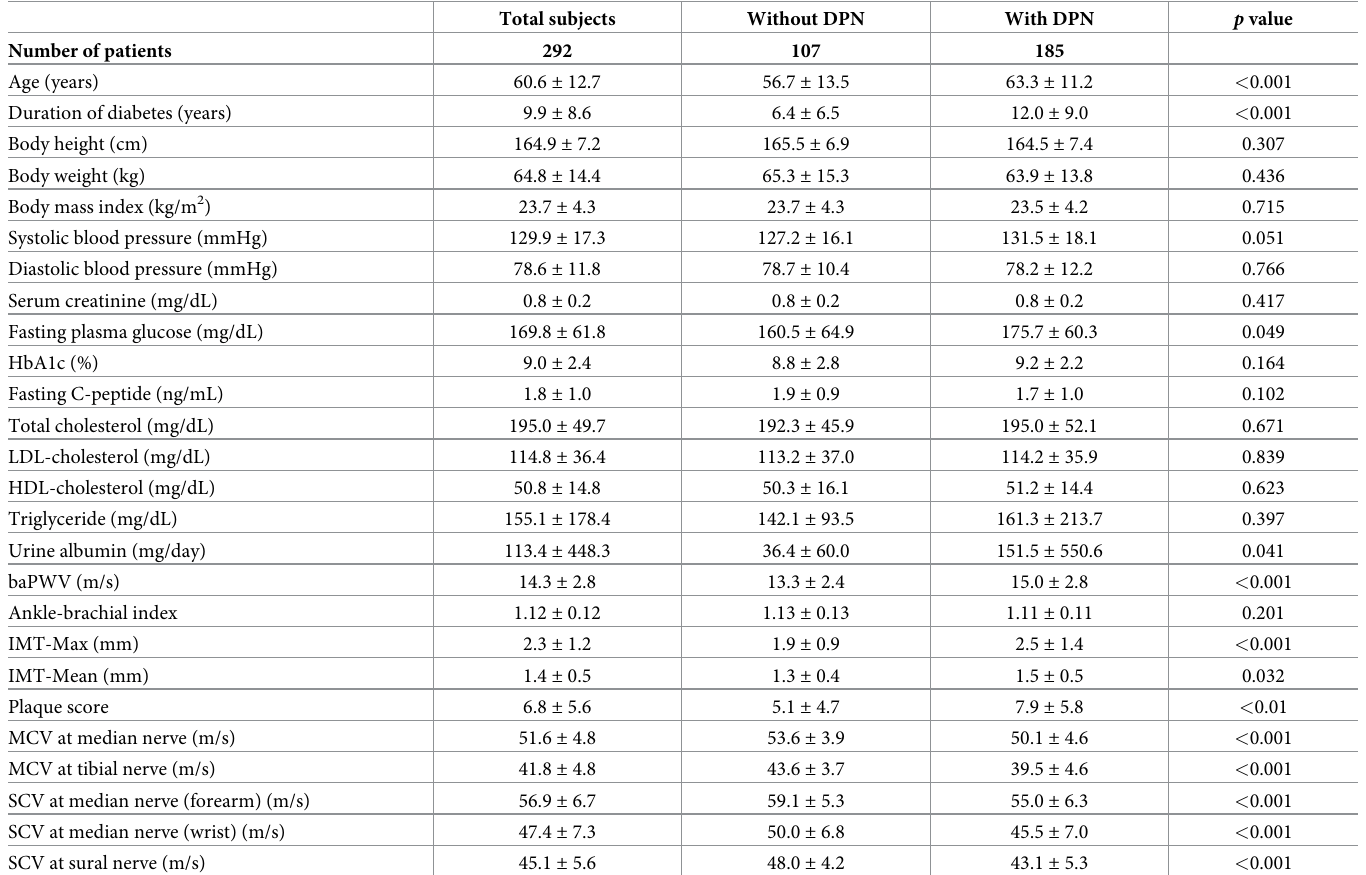
Table 1. Baseline characteristics of subjects. Total subjects Without DPN With DPN p